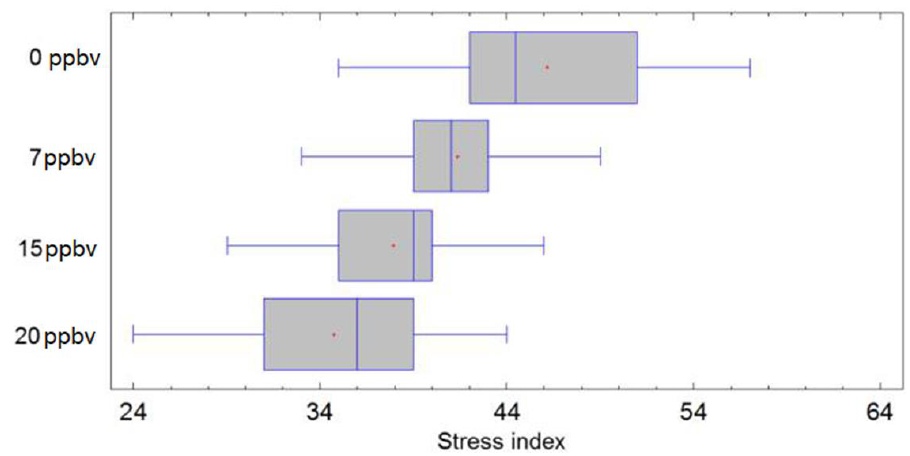
Figure 3. The stress index values from 30 participants (15 male and 15 female) at different monoterpene concentrations, as obtained from Exp 2.